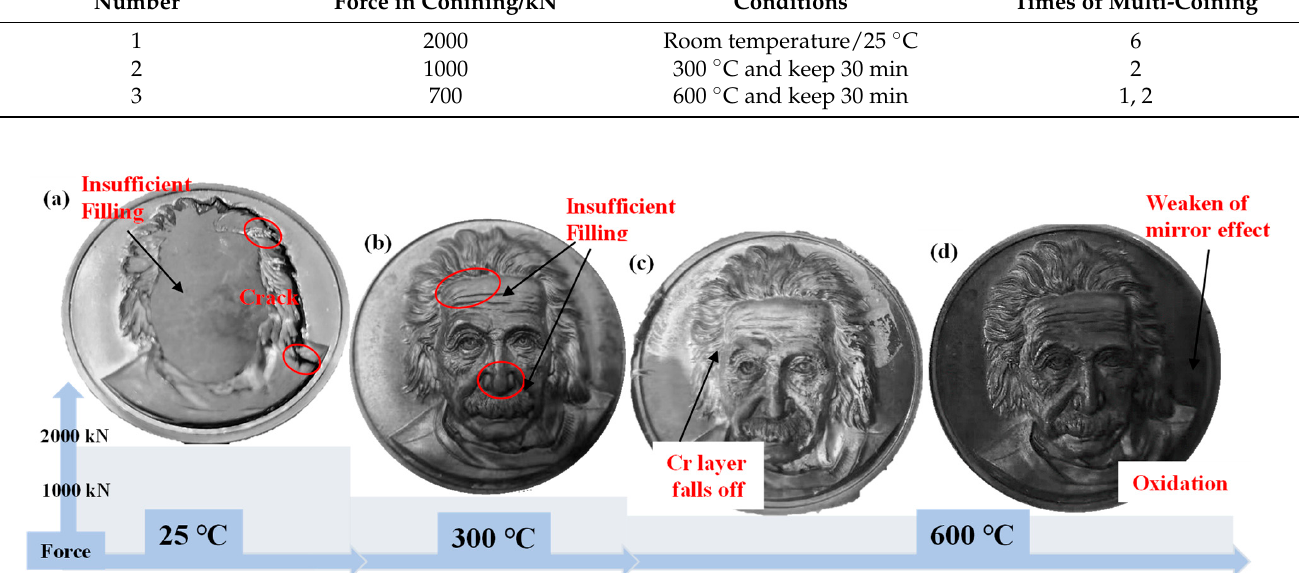
Figure 10. Comparison of experimental results: ( a ) 25 °C; ( b ) 300 °C; ( c ) 600 °C with 1th; and ( d ) 600 °C with 2th.